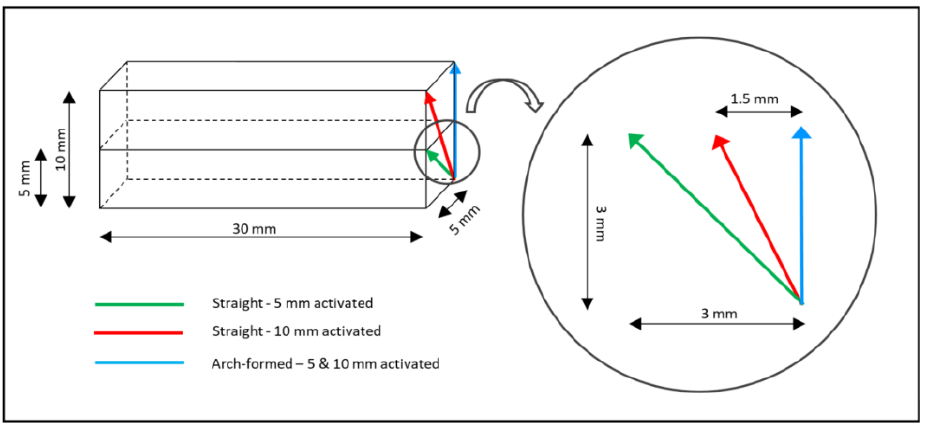
6). The velocity of the movement was 10 mm/sec for all configurations.